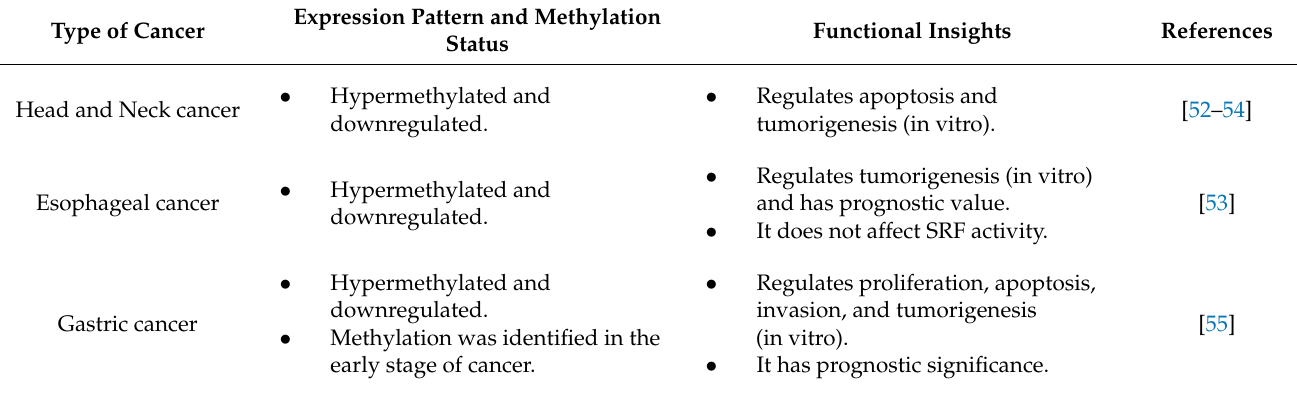
Table 1. Deregulation and functional significance of HOPX in cancer.